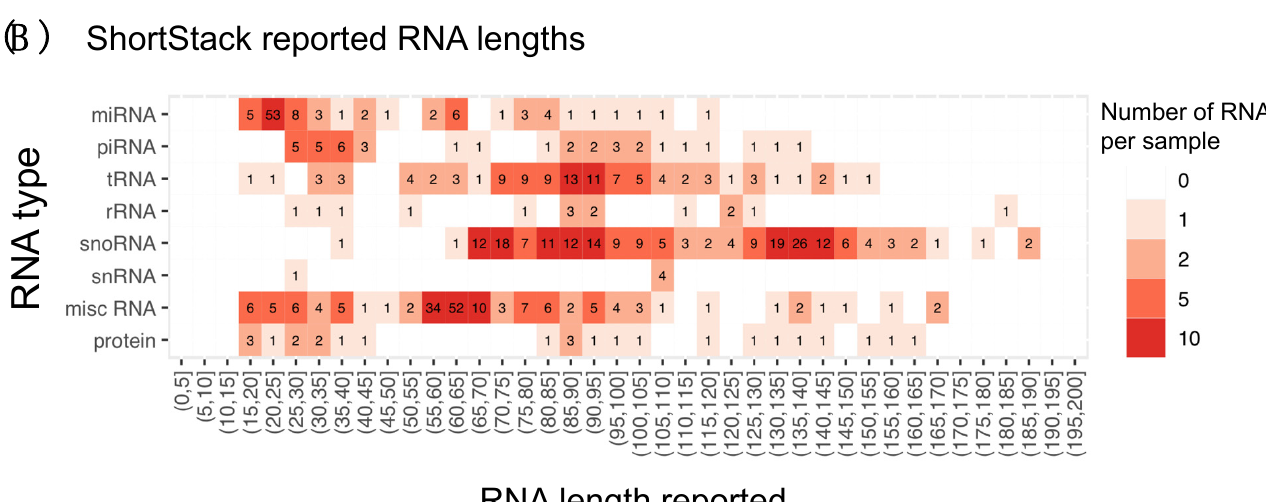
Figure 6. Length distribution of expressed annotated small RNA read clusters. The advantage of DANSR’s boundary optimization algorithm can be seen by comparing the length distribution of expressed annotated small RNAs identified by DANSR in the primary colon tumors to those identified by ShortStack. The expressed and annotated small RNAs are binned by length to different length ranges up to 200 nt. Each bin differs by 5 nt. Darker colors indicate that a higher average number of annotated small RNAs are expressed per sample in this range. ( A ) In DANSR’s results, 85% of miRNAs are concentrated in the 17–25 nt range, 60% of piRNAs are in the 20–40 nt range, and 93% of snoRNAs fall between 60 and 150 nt, as would be expected from the known structure of these small RNA species. ( B ) ShortStack, lacking a cluster boundary optimization step, reports expression of many features well outside their known length ranges; for example, 40% of miRNAs have lengths above 25 nt and 57% of piRNAs have lengths above 40